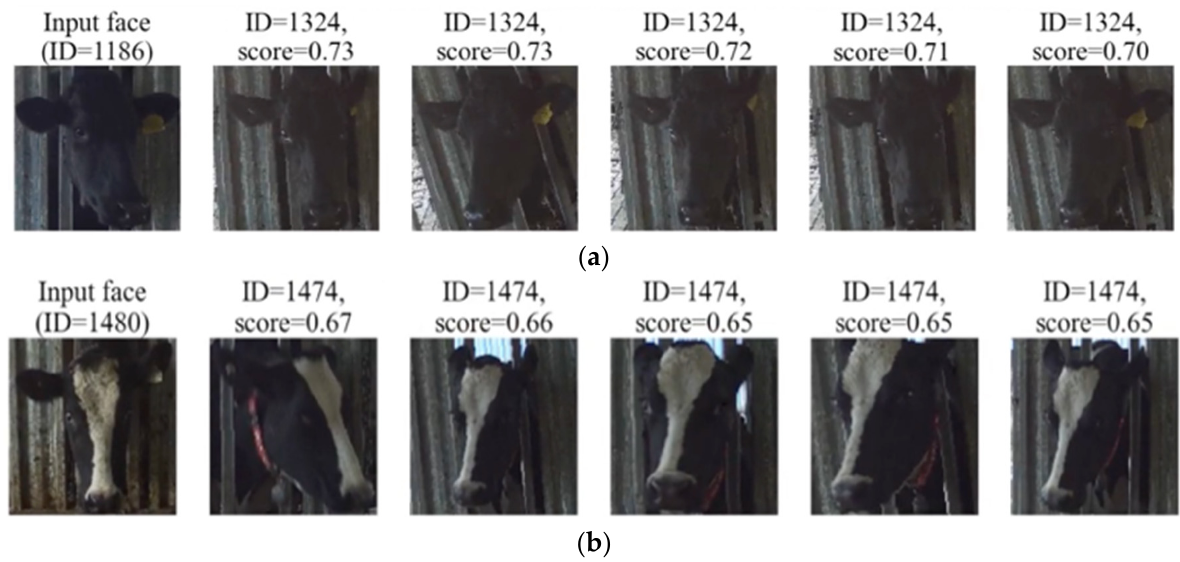
Figure 9. Example of ( a ) a miss case (ID = 1186 enrolled in database) and ( b ) a false alarm case (ID = 1480 not in database) in which input face looks very similar to an enrolled identity.